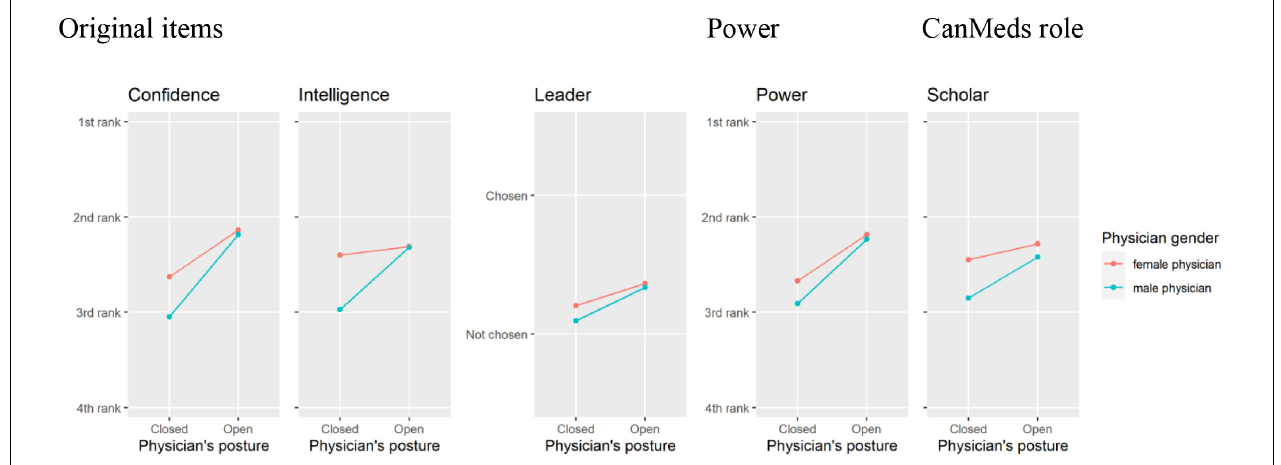
FIGURE 2 | Items for which open postures have a similar trend for male and female